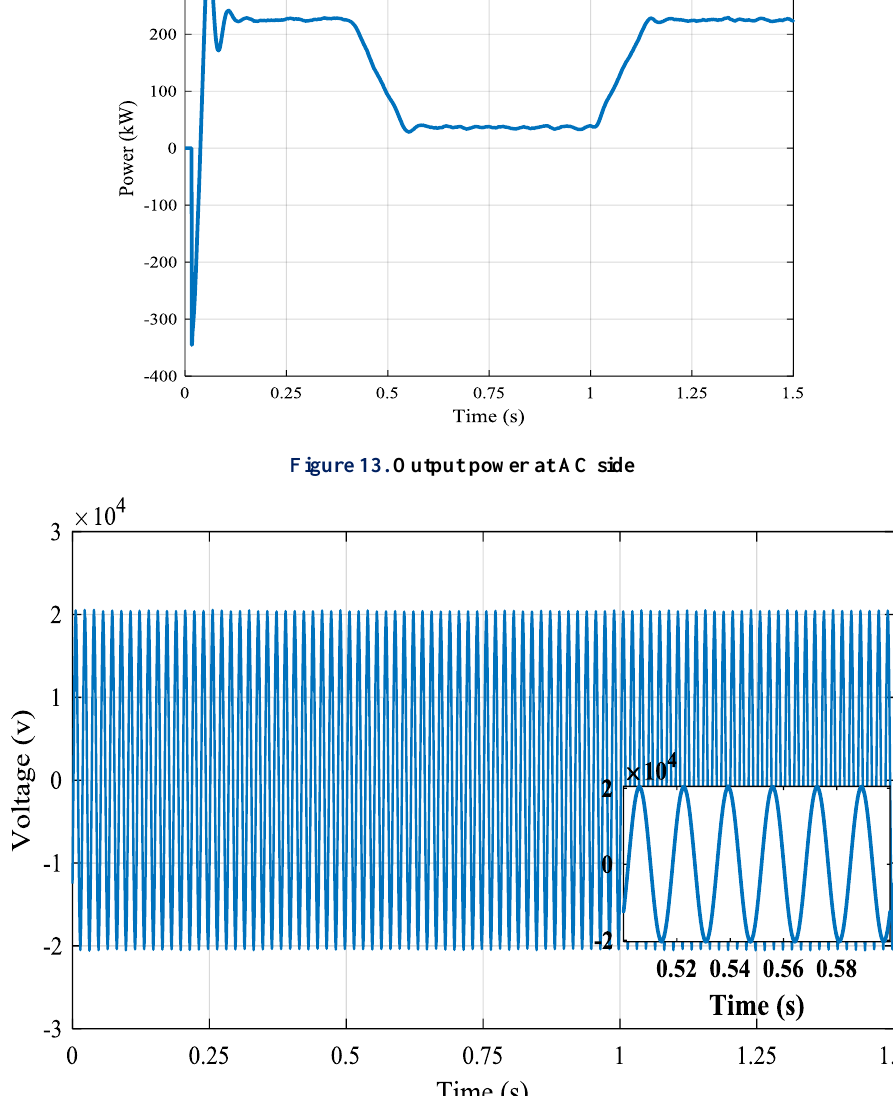
Figure 14. Voltage of connection point to the